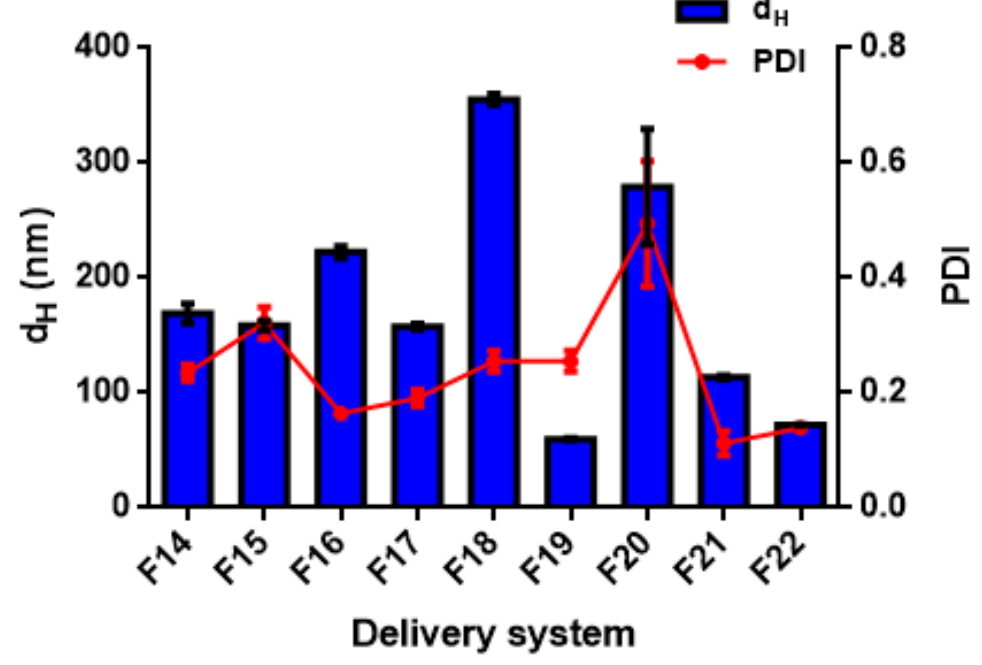
Figure 3. Hydrodynamic diameter (d H ) and polydispersity index (PDI) of TC2 EO nanoemulsions (formulations F14–F18 in Table 1) and nanoparticles (formulations F19–F22 in Table 1).